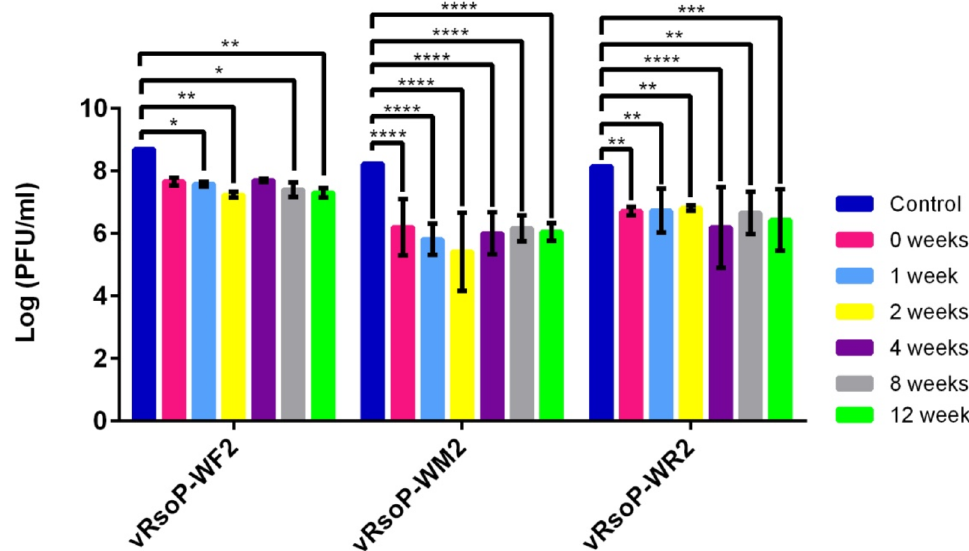
Figure 4. Stability of phages vRsoP-WF2, vRsoP-WM2 and vRsoP-WR2 lyophilized with trehalose at 0.5 M and stored at 4 ◦ C over time. Titration was carried out by the double layer agar method on CPG plates. Data are the means for assays performed at least in triplicate, and error bars indicate variation as the standard deviation. Asterisks above bars denote statistically significant differences between the two signaled columns: * p < 0.05, ** p < 0.01, *** p < 0.001, **** p <